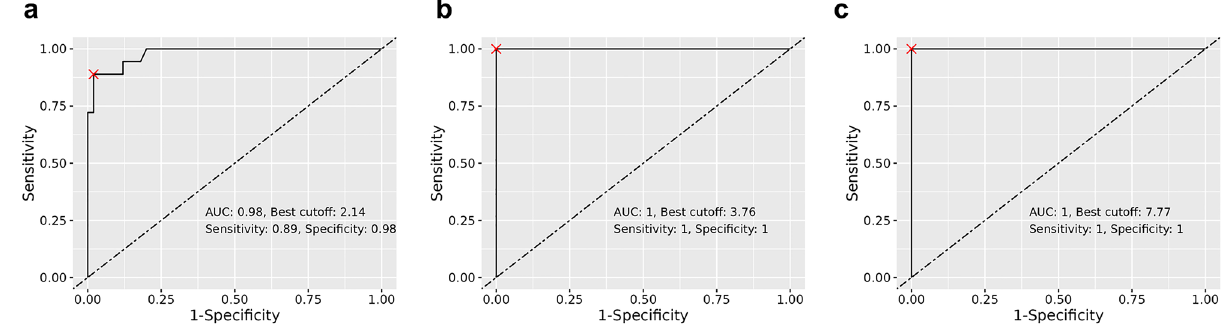
Figure 4. ROC analysis of SUVmax for differentiating the visual grade, DS. SUVmax values of 2.14, 3.76 and 7.77 were selected as the optimal cutoff values for differentiating DS 0/1 ( a ), 1/2 ( b ), and 2/3 ( c ), respectively.